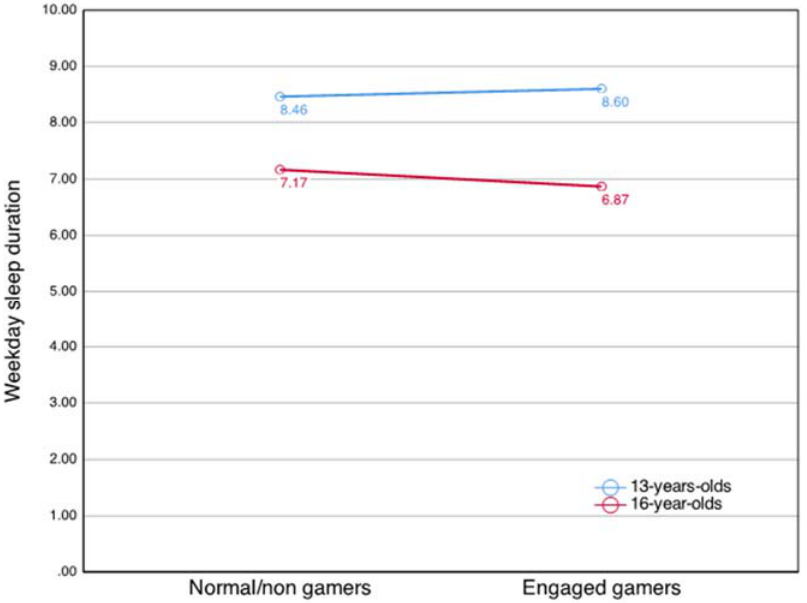
Figure 1. Effect of age on the association of engaged gaming and weekday sleep duration. Table 4. Crude and adjusted associations of gaming behavior and social jetlag *.